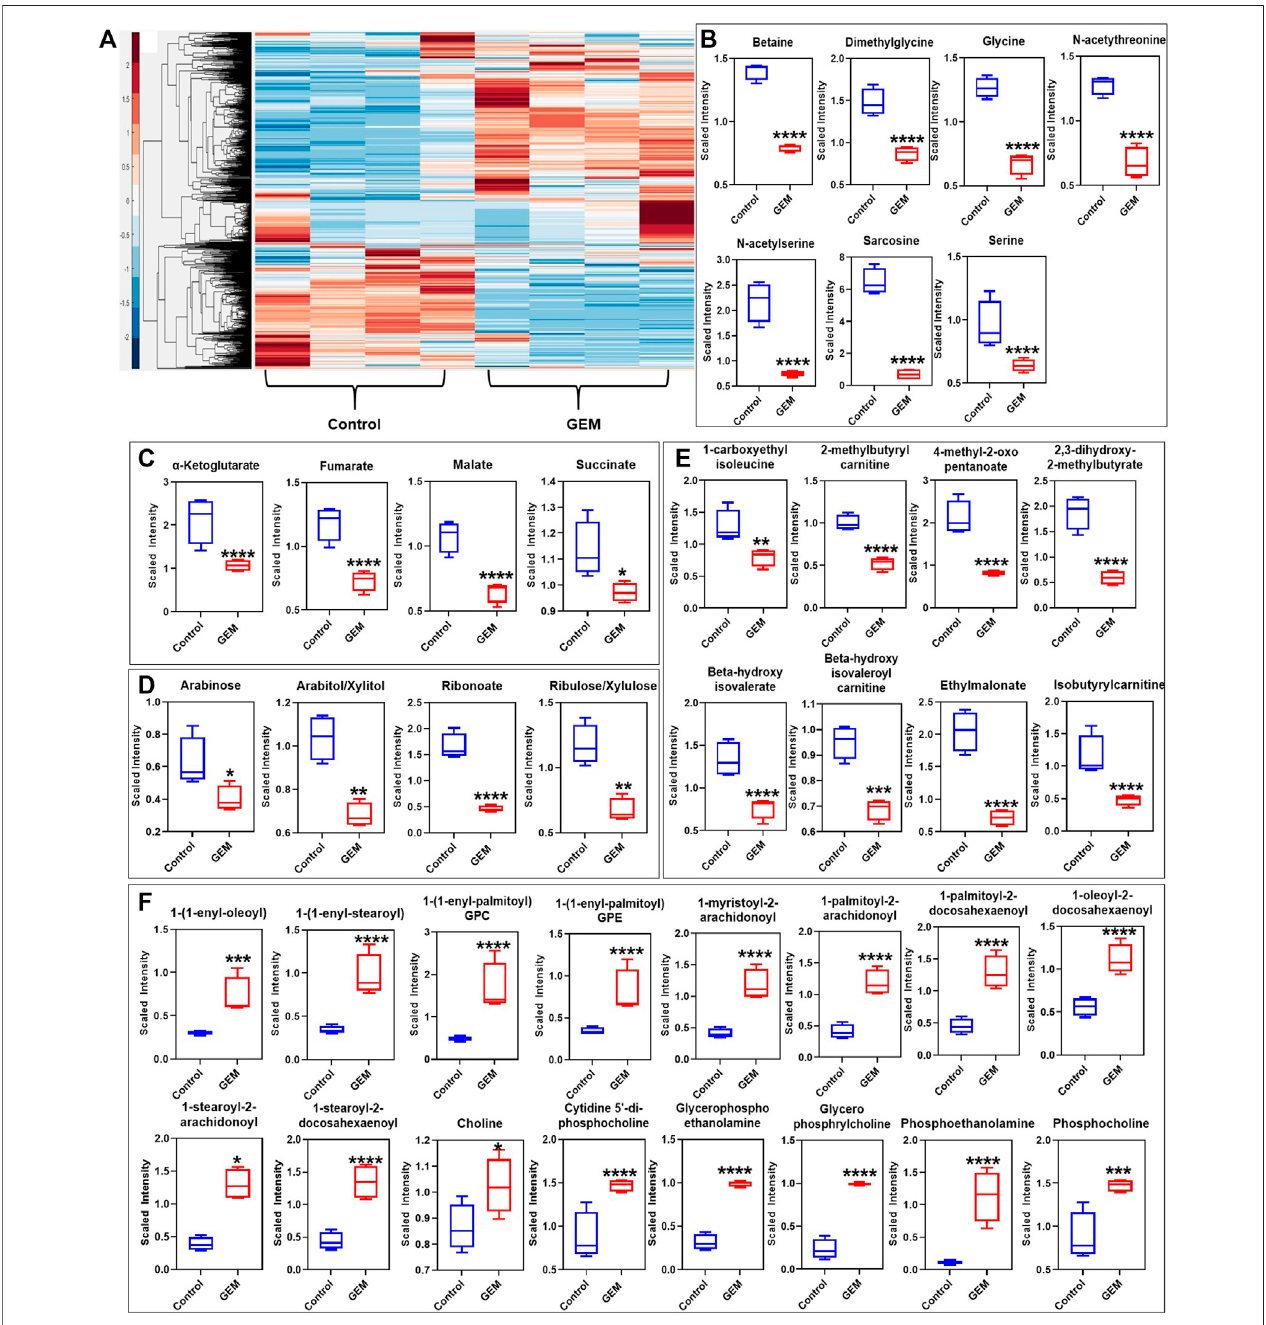
FIGURE 2 | Metabolic alterations in GEM persisters: (A) GEM-treated and untreated A375 cells were collected for MS analysis to measure their metabolite contents. Unsupervised clustering of the metabolomics data was performed with the Clustergram function in MATLAB. The generated heat maps show metabolite clusters that are upregulated (red) or downregulated (blue) in the treated group compared to the untreated control group. Each column representsa biological replicate; eachrowrepresentsametabolite. N (cid:1) 4. (B – F) Boxplotsshowthemetabolitesfromtheone-carbonmetabolismpathway (B) ,theKrebscycle (C) ,thePPP (D) ,the BCAA metabolism pathways (E) , and the lipid metabolism pathway (F) that are signi fi cantly altered in GEM persisters compared to control cells. Statistical signi fi cance was assessed with ANOVA (* p < 0.05, ** p < 0.01, *** p < 0.001, and **** p < 0.0001). N (cid:1) 4.